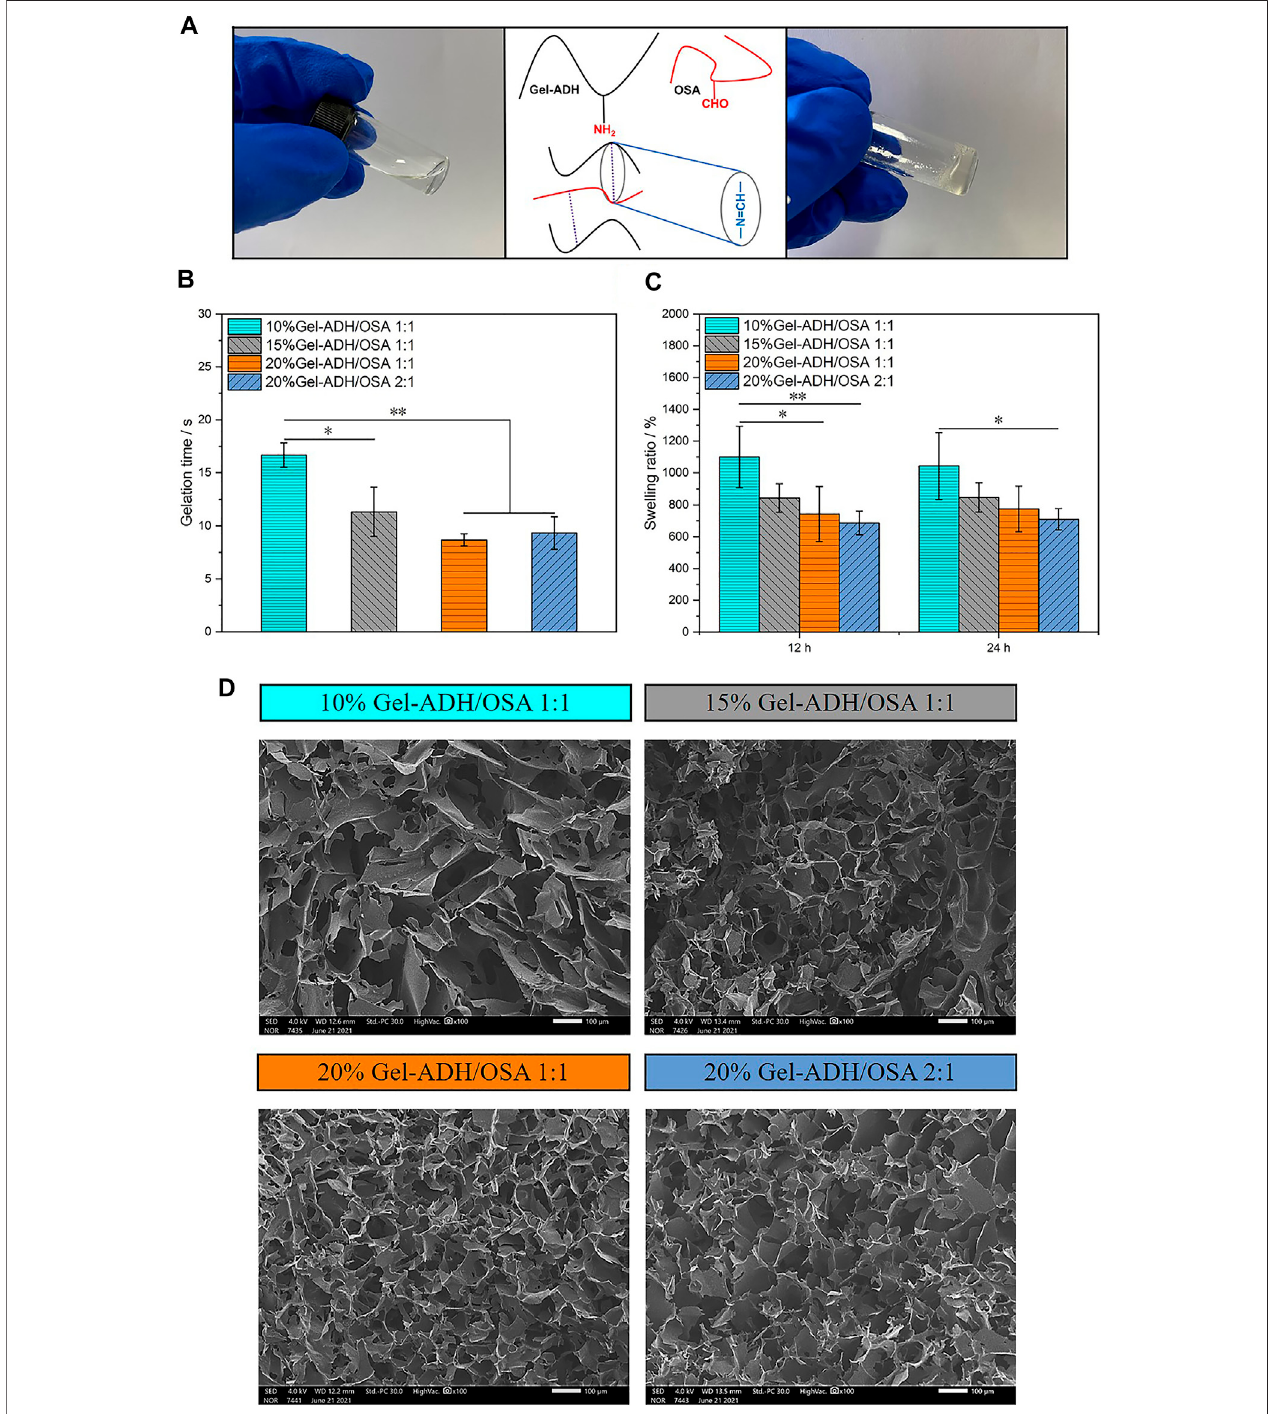
FIGURE 3 | (A) Schematic illustration of the preparation of Gel-ADH/OSA hydrogels. (B) Gelation time, (C) swelling ratio, and (D) SEM images of Gel-ADH/OSA hydrogels with different components and concentrations (scale bar (cid:1) 100 μ m, * p ＜ 0.05, ** p ＜ 0.01, n (cid:1) 3).